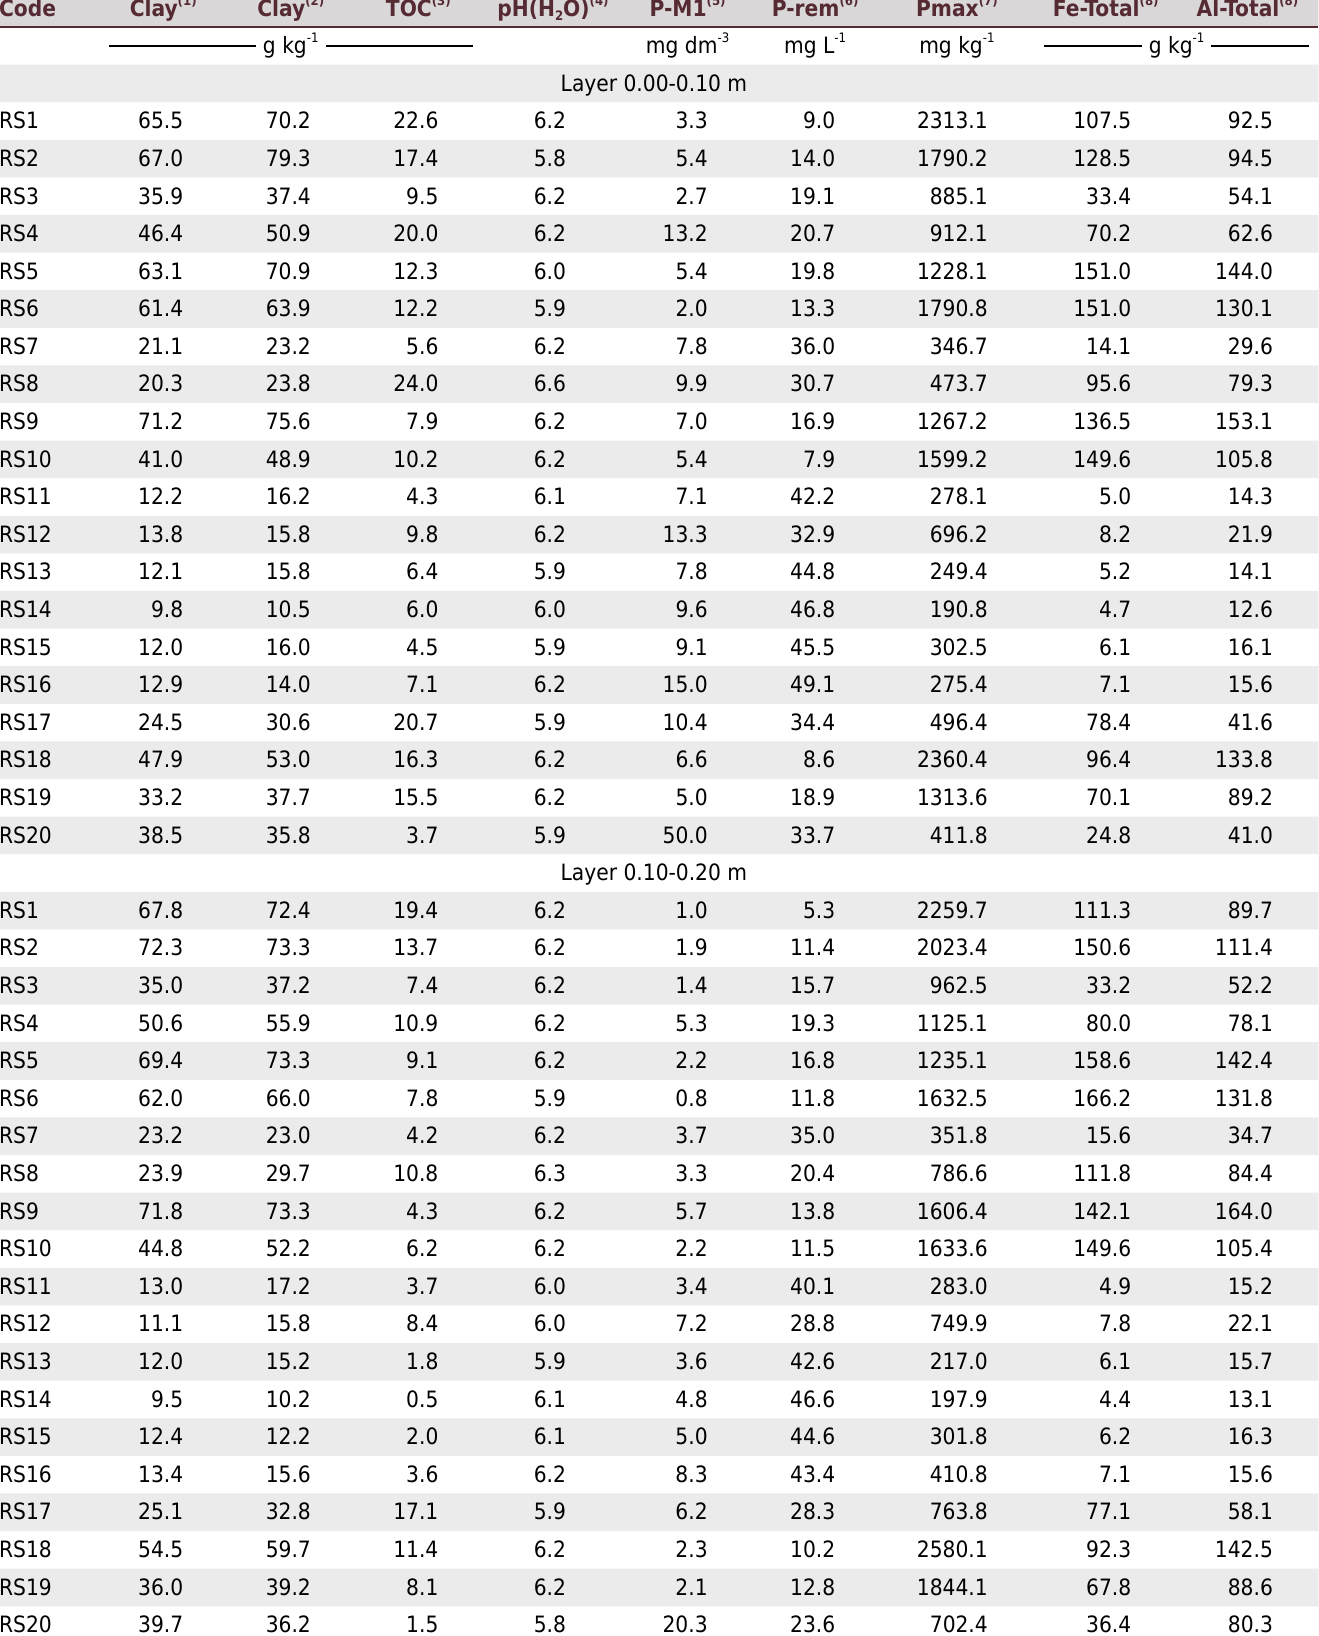
Table 2. Clay content and chemical characterization of the 20 soils collected in the 0.00-0.10 and 0.10-0.20 m layers in the state of Rio Grande do Sul, Brazil